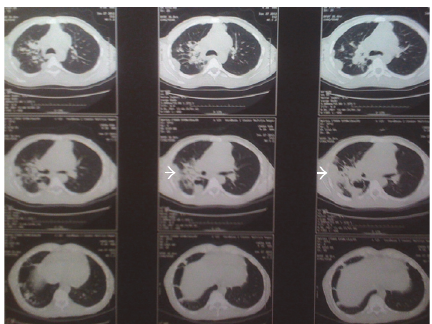
Figure 2: CT scan of the chest showing lesion in the lungs. Biopsy of these lesions was inconclusive.